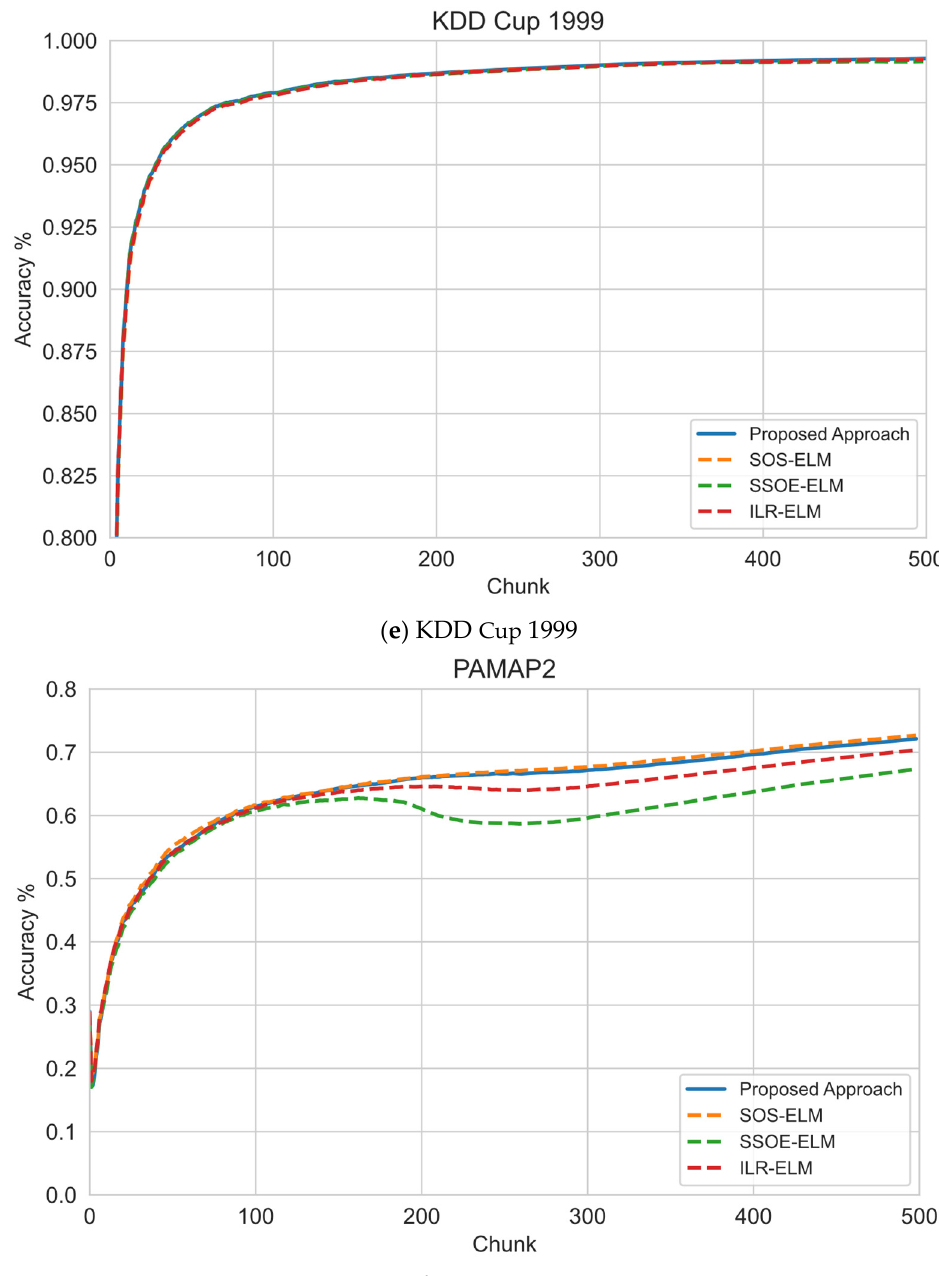
Figure 4. Sequential learning evaluation of this approach versus optimal RBF kernel hyperparameters for other approaches: ( a ) on sensorless drive data set, this approach performed second best but was comparable to the SOS-ELM approach; ( b ) on magic gamma data set, this approach’s performance was comparable to the best approach, ILR-ELM; ( c ) on HAR data set, this approach’s performance was slightly worse than other approaches; ( d ) on crop mapping data set, this approach performed close to other approaches except SSOE-ELM; ( e ) on KDDCup1999 data set, all approaches had a similar learning performance; ( f ) on PAMAP2 data set, this approach had a more stable learning performance compared to other approaches when exposed to a noisy data set.